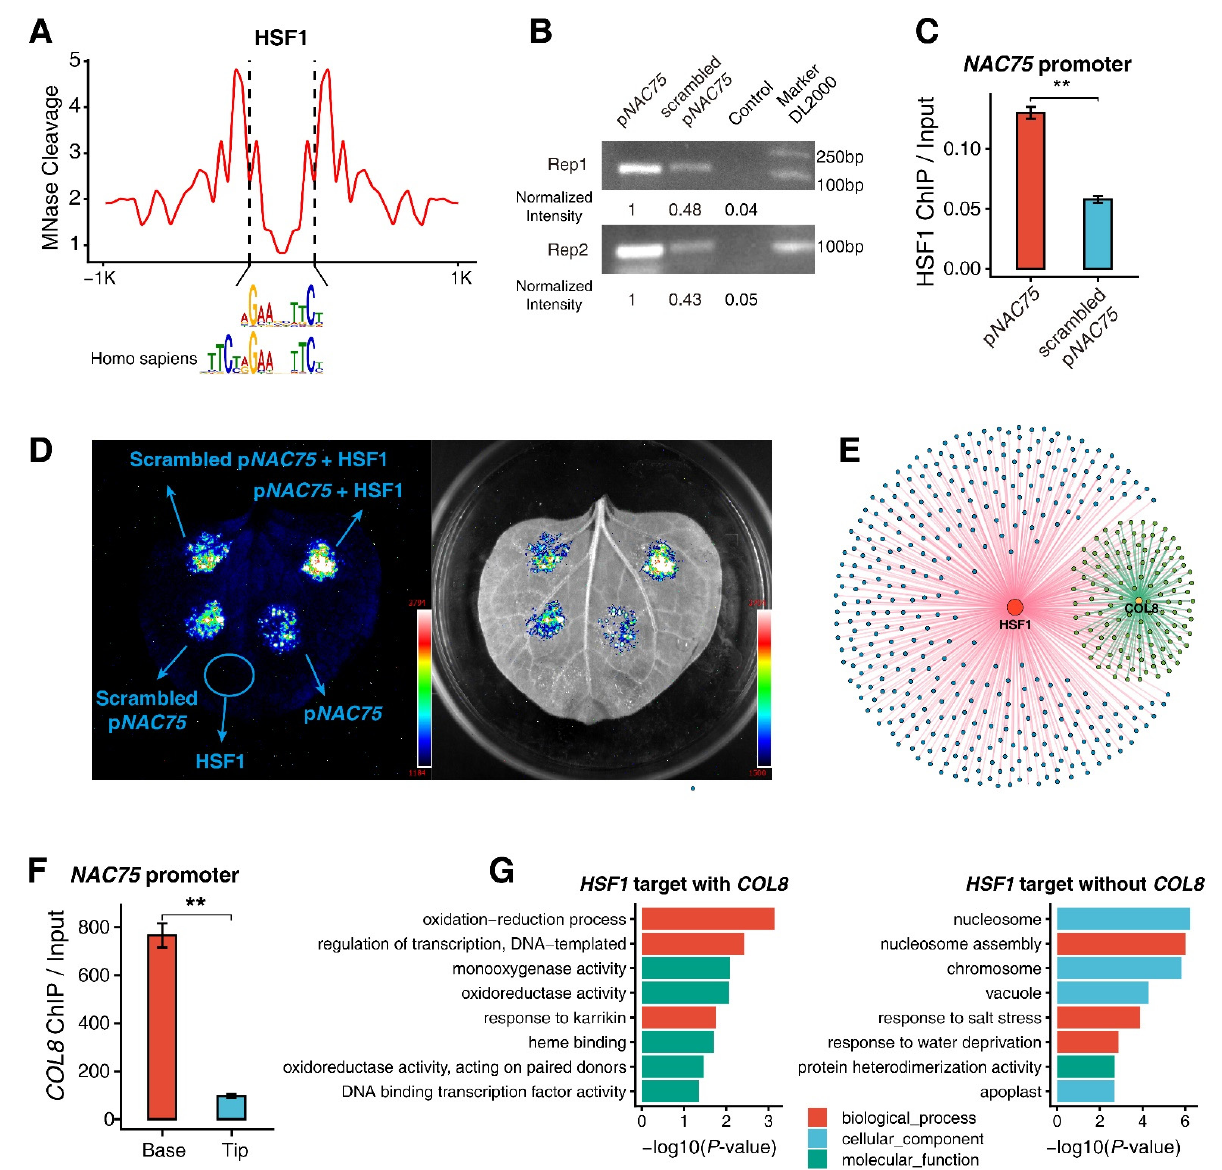
Figure 6. Validation of HSF1 binding motif. ( A ) Footprinting assay of the HSF1 binding motif. ( B , C ) HSF1 ( B ) IP-PCR or ( C ) IP-qPCR assays for assessing the binding of HSF1 with natural HSF1 binding sites and the corresponding scrambled sequences. ( D ) Dual-luciferase reporter assay using Nicotiana benthamiana leaves co-infiltrated with the combination of P NAC75 : LUC with 35S:: HSF1 . ( E ) HSF1 - and COL8 -regulated network. ( F ) COL8 qPCR assays for assessing the binding of COL8 in NAC75 promoter in leaf tip and base. ( G ) GO-term enrichment analyses for HSF1-targeted genes with or without the COL8 binding sites. The ChIP signal were presented as mean ± SD from three technical replicates in ( C , F ). Significance test was determined using one-sided t -test, ** indicates p < 0.01.